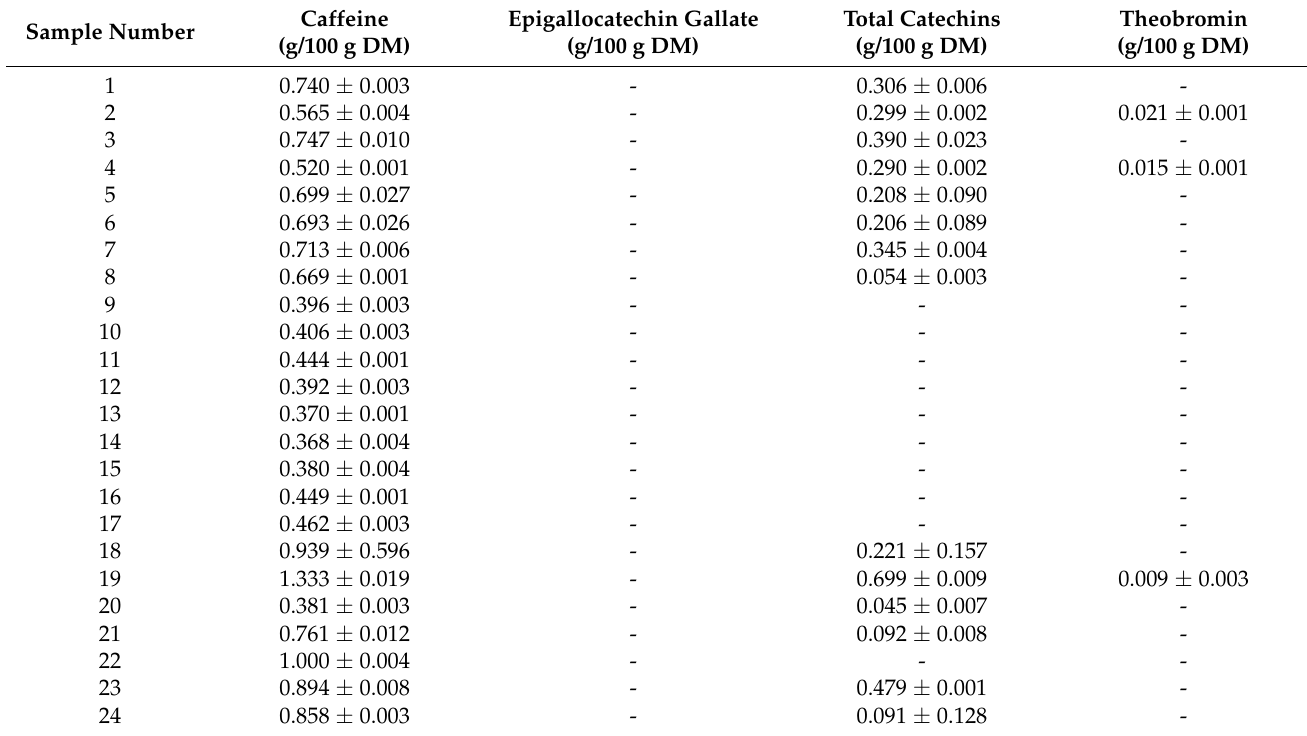
Table A2. Results of the HPLC analysis for caffeine and catechins.